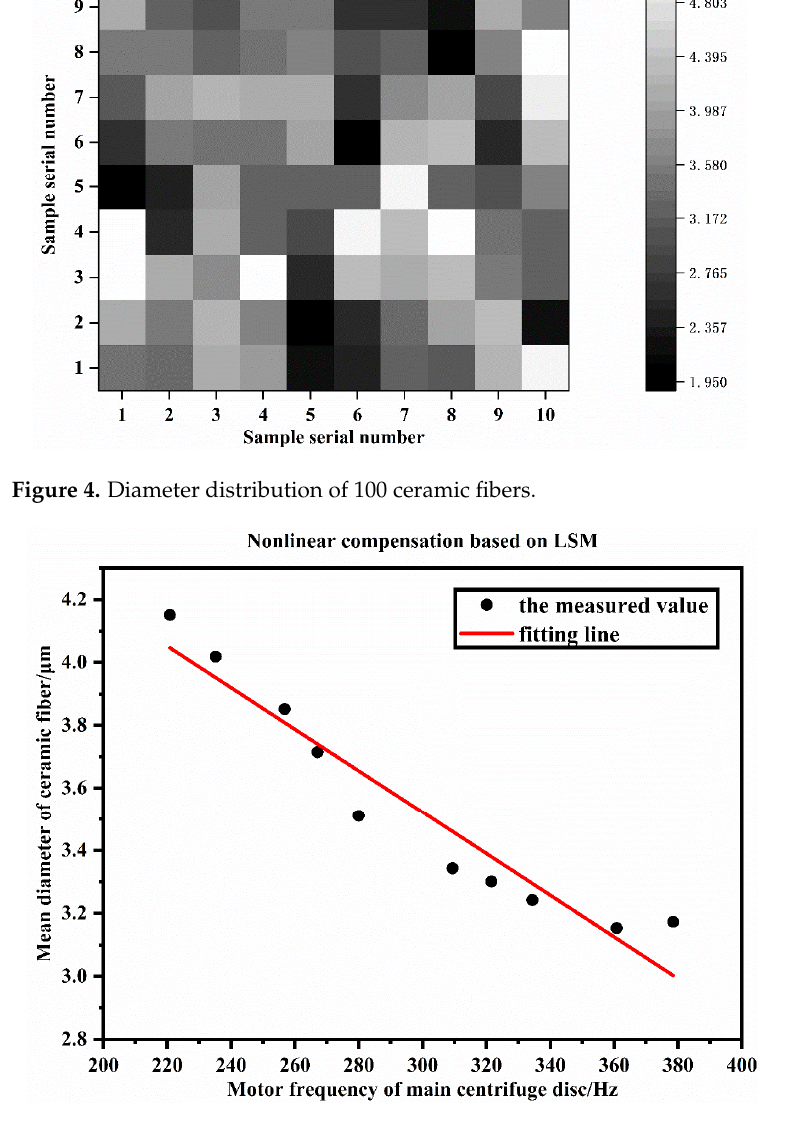
Figure 5. Nonlinear compensation model based on LSM. Table 1. The Mean Fiber Diameter Date with Ten Different Main Motor Frequencies.